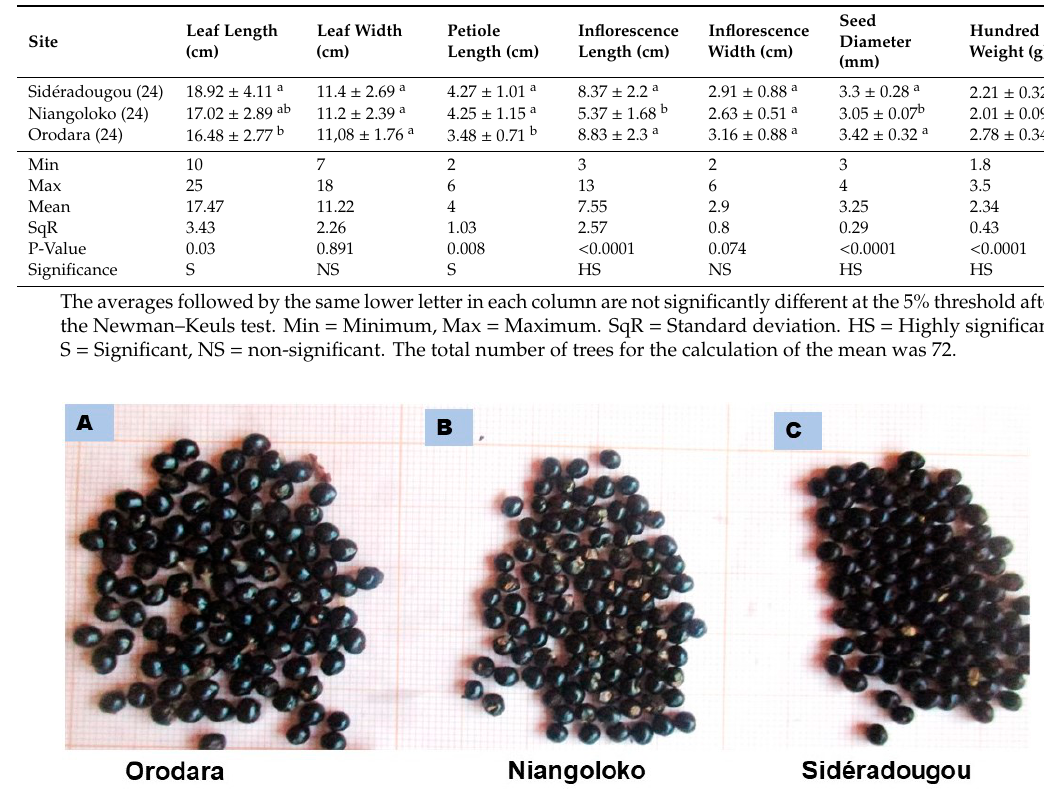
Figure 4. Seeds of Z. zanthoxyloides from Orodara ( A ), Niangoloko ( B ), and Sidéradougou ( C ).